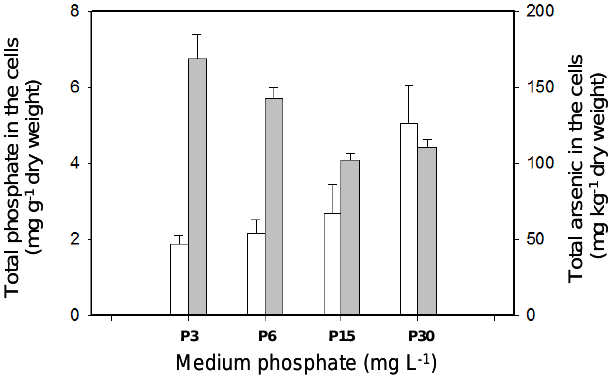
Figure 3. Total concentrations of As and P, when exposed to 40 μM As(V) under different P levels for 20 h incubation. White columns: phosphate levels; gray columns: arsenic levels. All data are the means ± SE ( n = 4).